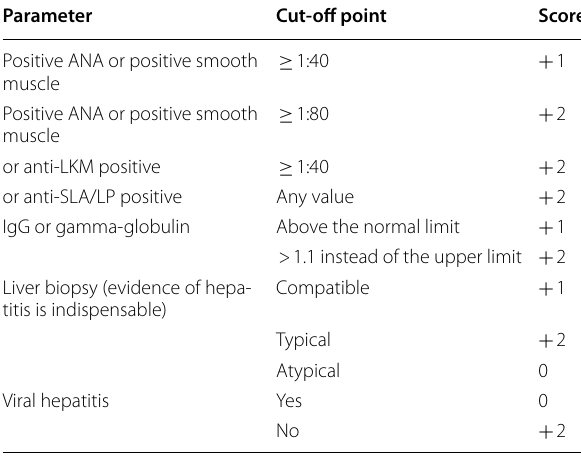
Table 1 Simplified criteria for AIH diagnosis—2008 [30]